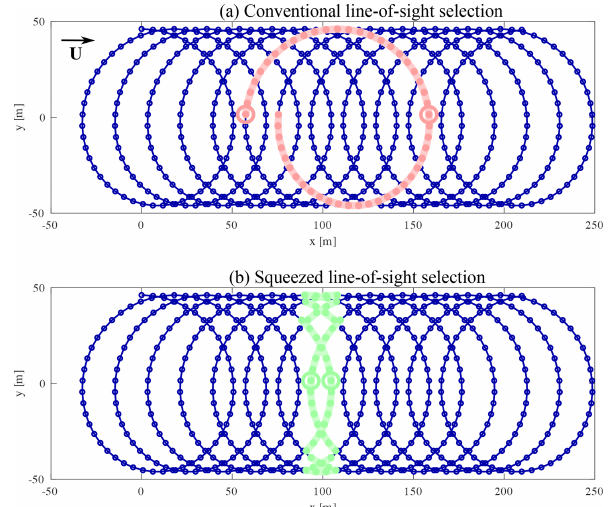
Figure 4. Selection of line-of-sight measurements for the recon- struction of one wind vector for when ( a , in red) conventional VAD processing and ( b , in green) the method of squeezed measure- ment circles is applied. Within the red and green segments, small red and green rings indicate the particular beams selected for two- beam processing. In this example, U = 19 . 5ms − 1 , D C = 92 . 3m and f S =